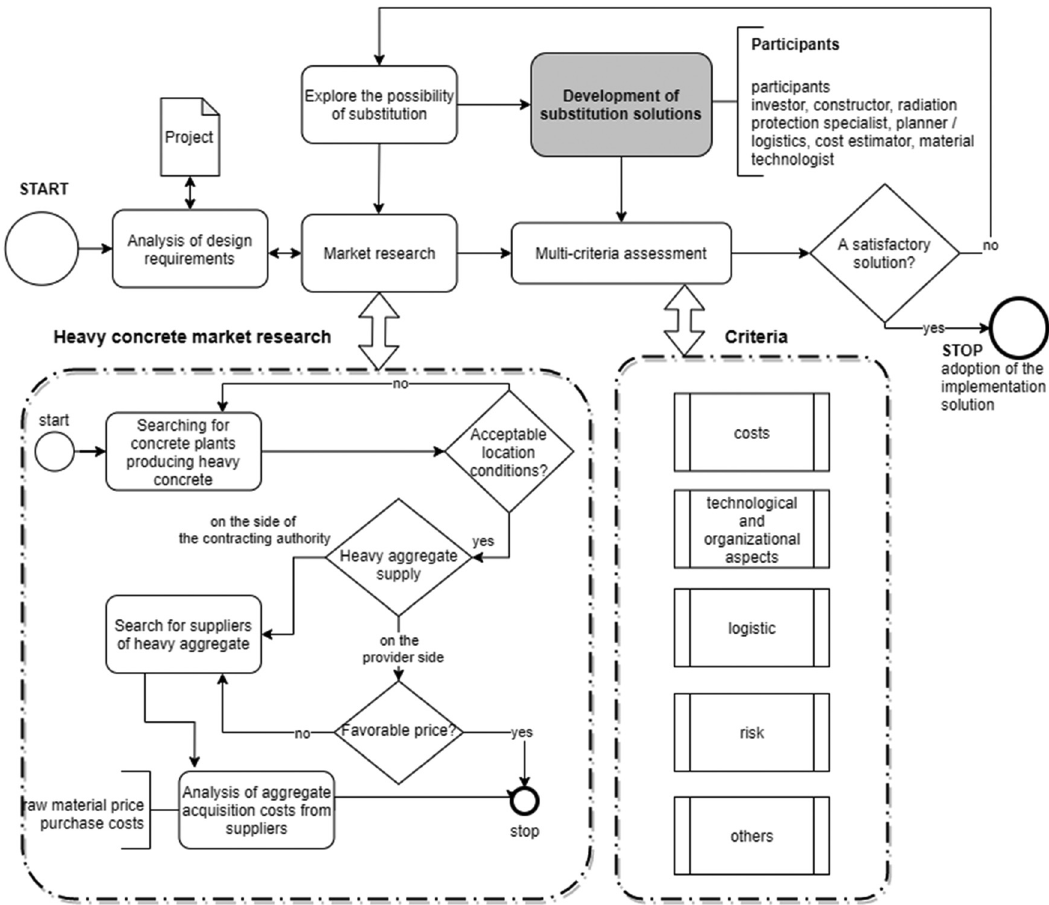
Figure 5: A schematic diagram of the decision - making process in the area of the